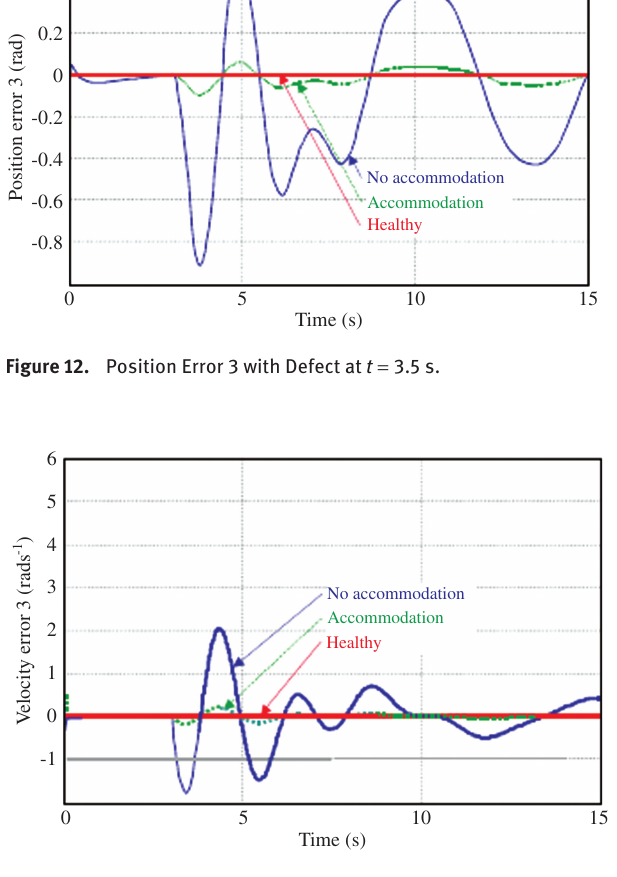
Figure 13. Velocity Error 3 with Defect at t = 3.5